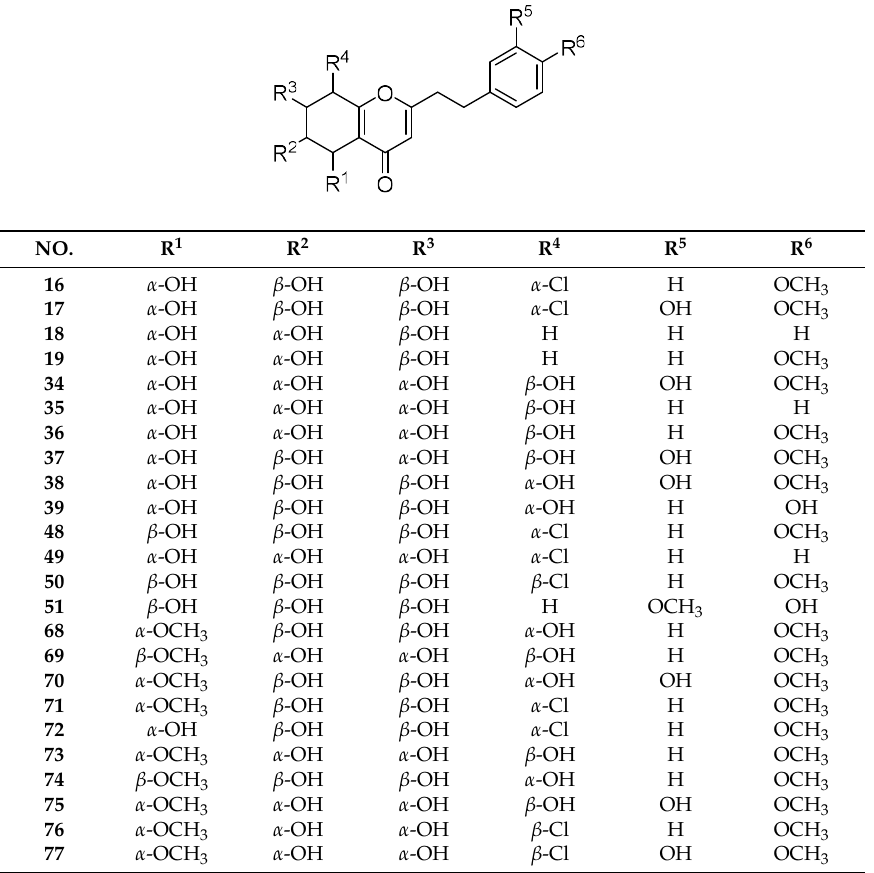
Figure 3. Structures of 5,6,7,8-tetrahydro-2-(2-phenylethyl)chromones identified in agarwood.